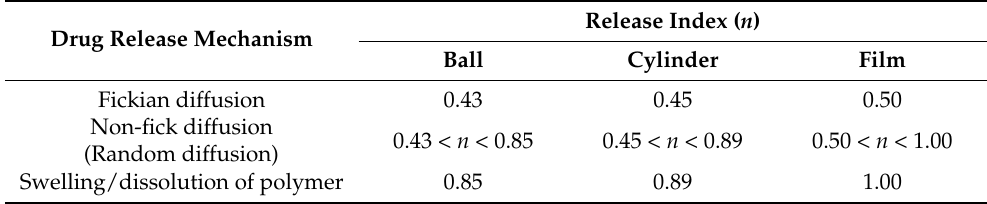
Table 4. Relationship between the release index and the shape of the drug release mechanism or the drug release system in the Korsmeyer–Peppas model